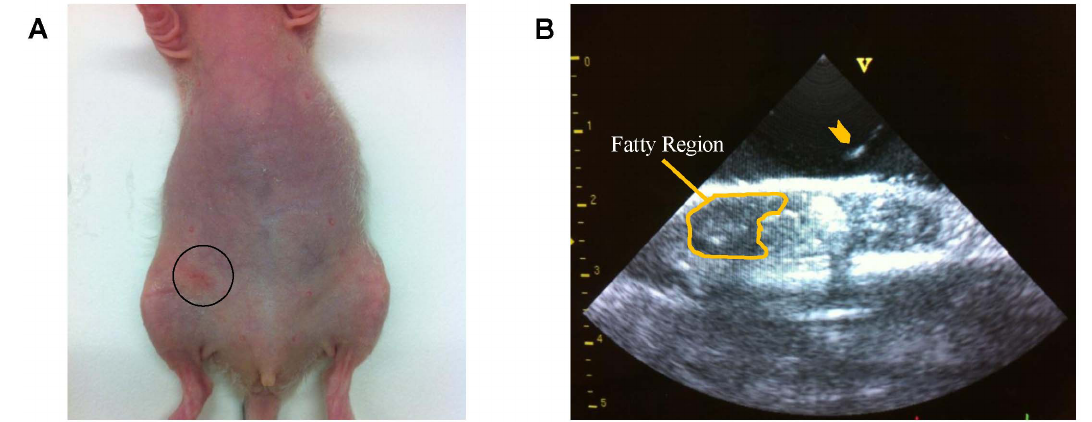
Figure 1. Cell inoculation under ultrasound image guidance. (A) Cancer cells were injected through the skin (circle) and into the lower mammary fat pad under ultrasound image guidance. (B) Ultrasound image showing needle tip (arrowhead) and mammary fat pad.